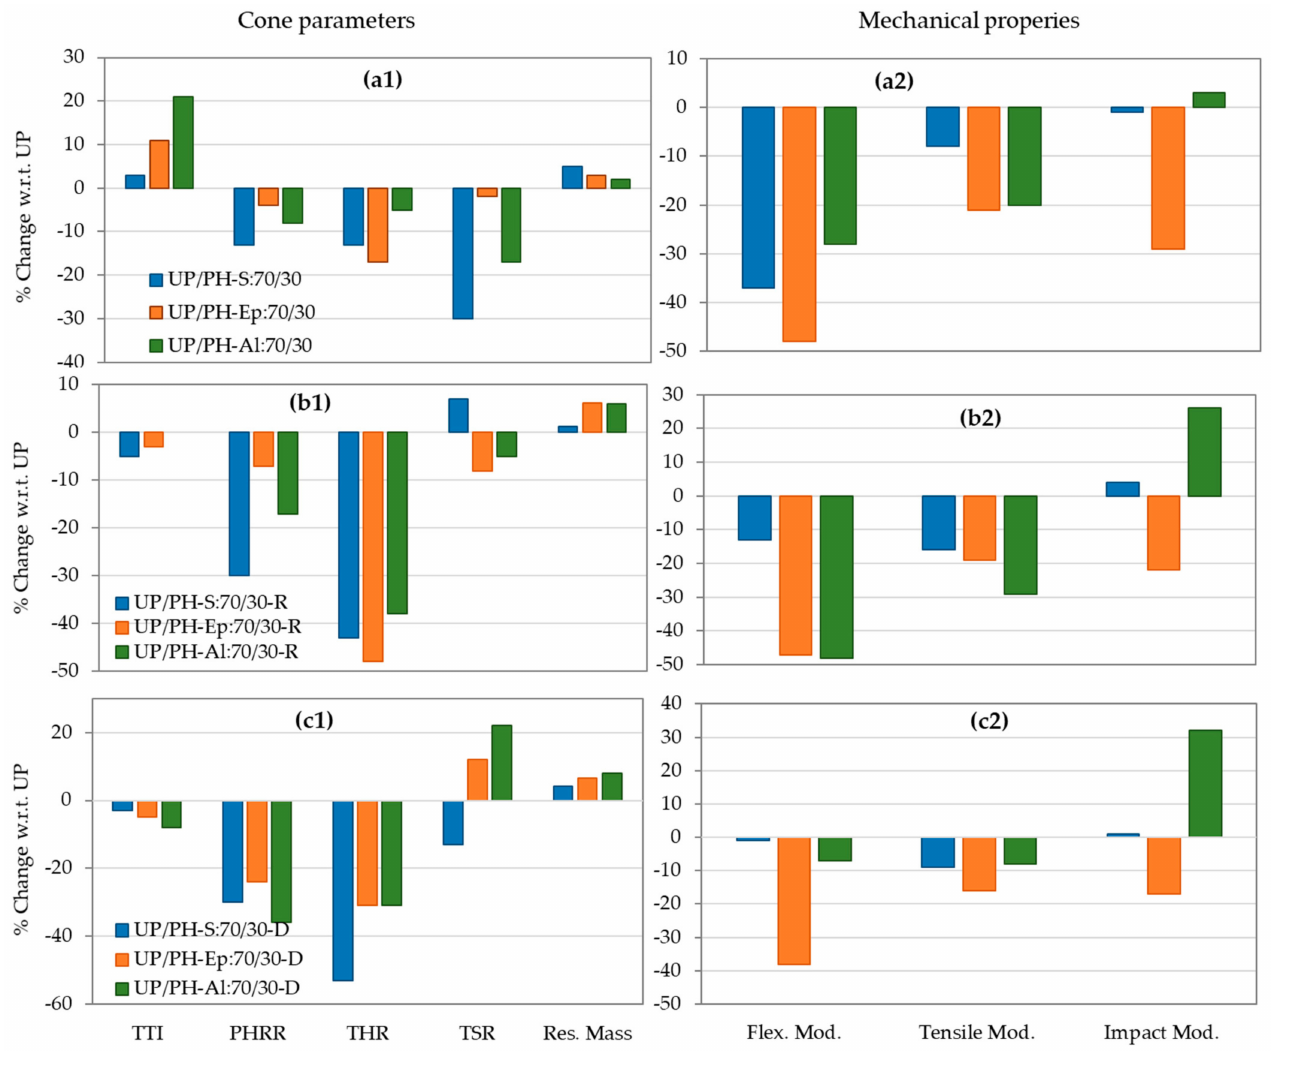
Figure 2. Percent changes in cone parameters and flexural/tensile moduli/impact moduli of GFRC from ( a1 , a2 ) UP/PH resins, ( b1 , b2 ) UP/PH containing RDP and ( c1 , c2 ) UP/PH containing DOPO w.r.t control GFRC of